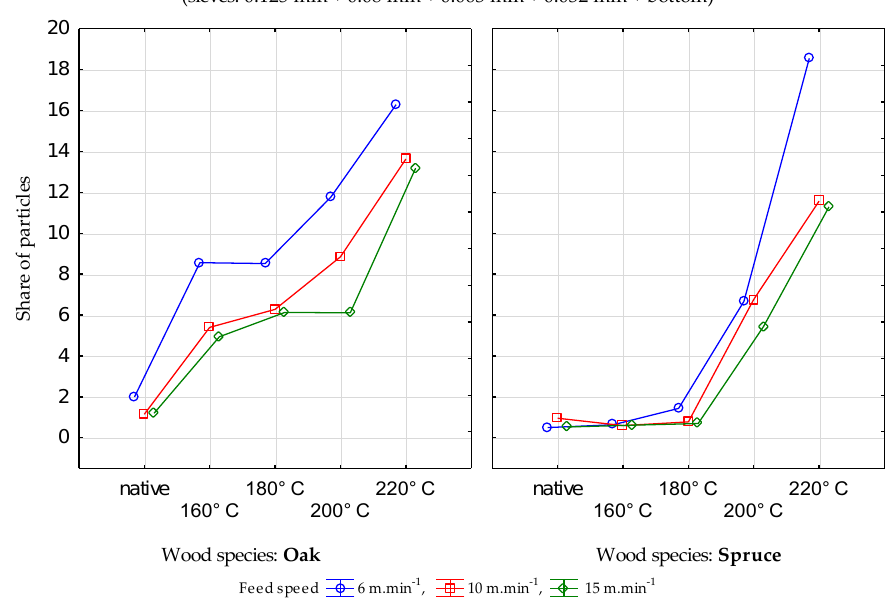
Figure 3. Percentage of particles in the mesh size 0.125 mm, 0.08 mm, 0.063 mm, 0.032 mm and the bottom—fine fraction depending upon temperature the modification of oak and spruce.